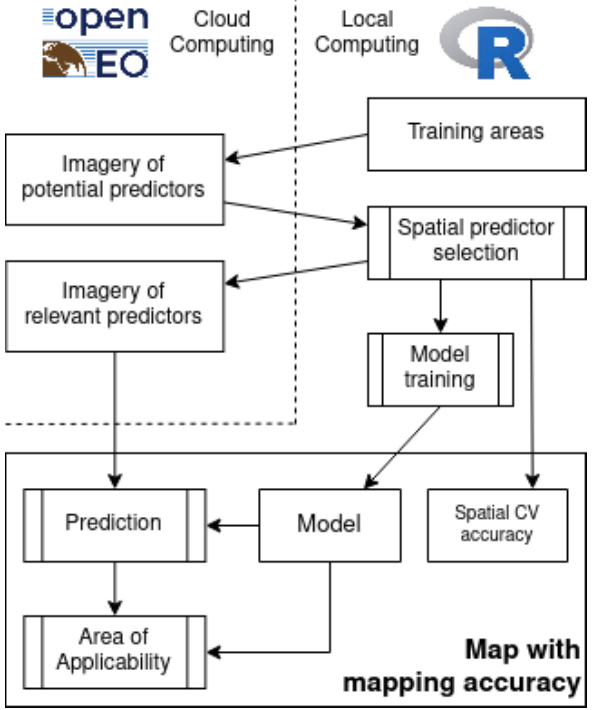
Figure 1. Outline of the